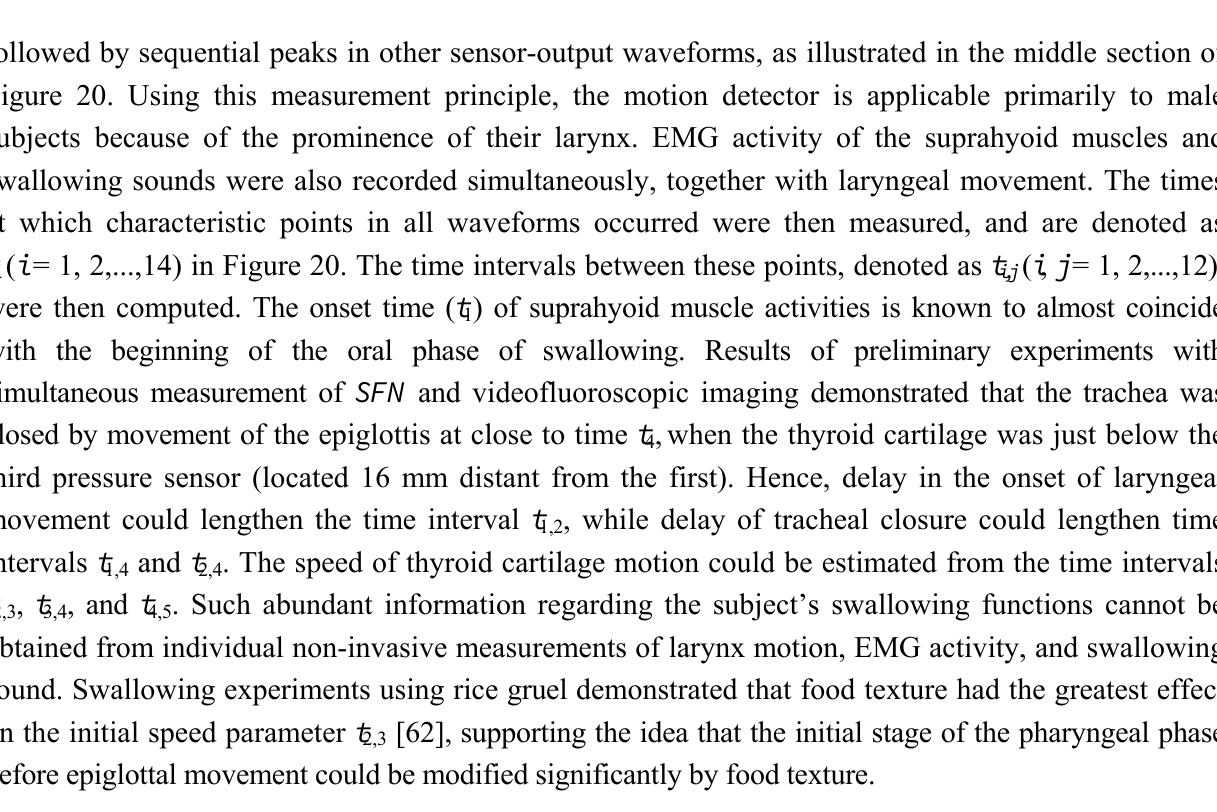
Figure 19. Swallowing-function evaluation system, SFN -1 [62], capable of measuring laryngeal movement, EMG activity of suprahyoid muscles, and swallowing sounds. A: sensing surface of laryngeal movement detector. B: sensors mounted on the anterior region of the